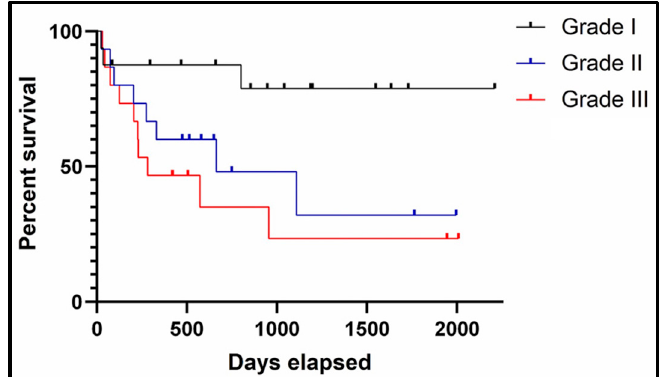
Figure 4. Kaplan–Meier survival curve for histological grade [41]. The black line represents cats with grade I (low grade) soft tissue sarcomas, the blue line represents cats with grade II (intermediate grade) soft tissue sarcomas and the red line represents cats with grade III (high grade) soft tissue sarcomas. Tick lines represent censored cases (lost to follow-up or died of non tumour-related causes).